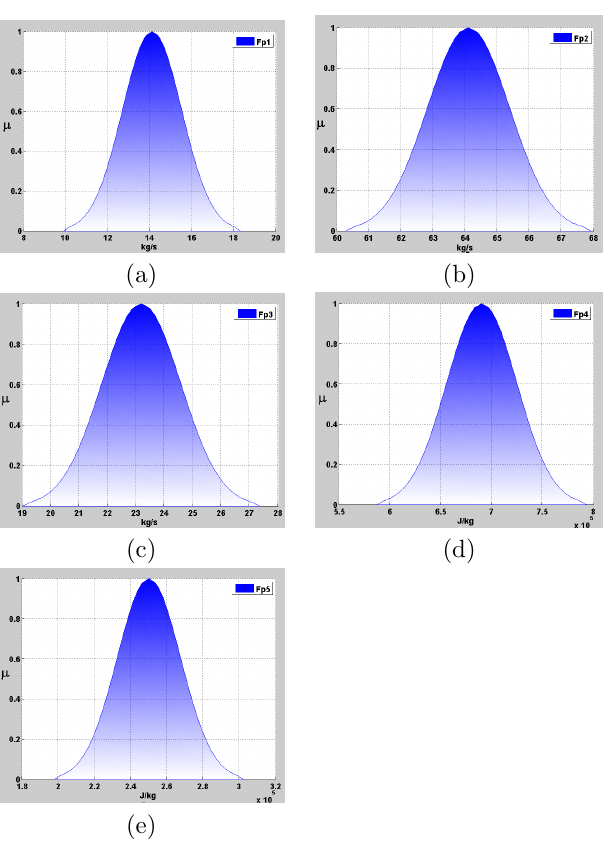
Figure 7. Fuzzy input parameters of a furnace system (a) p 1 = W F , (b) p 2 = W A , (c)